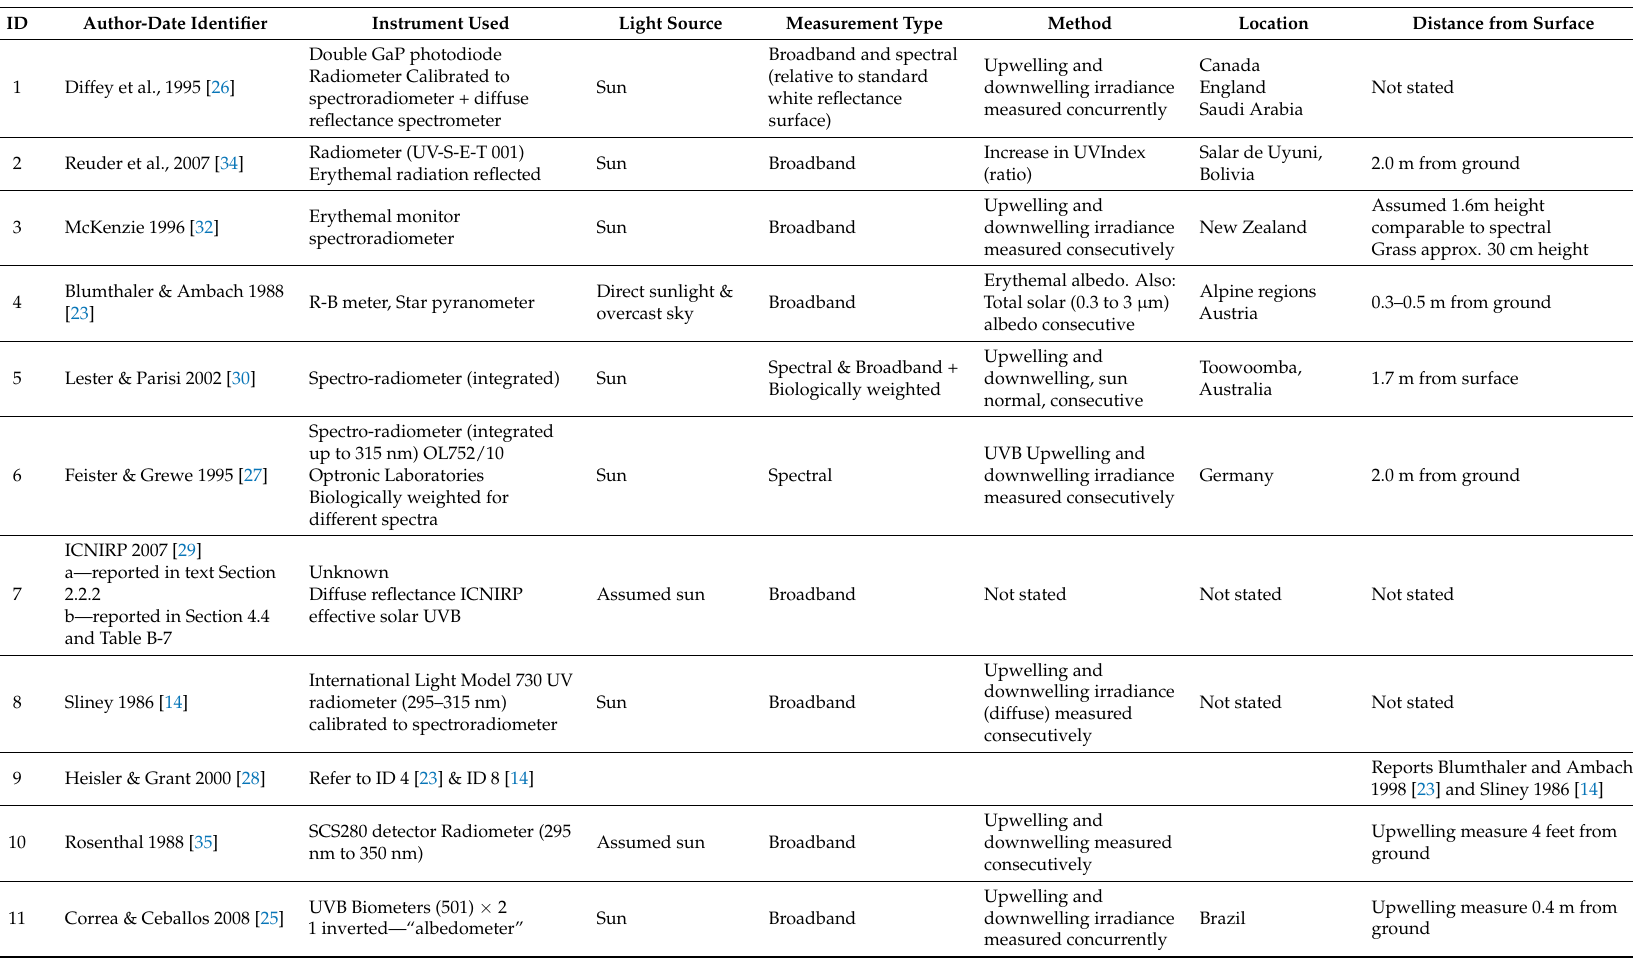
Table 2. Publications with reportable localised UV albedo measurements including methodology. The identification number (ID) is used to identify the measurements compiled in Tables 3 and 4 per